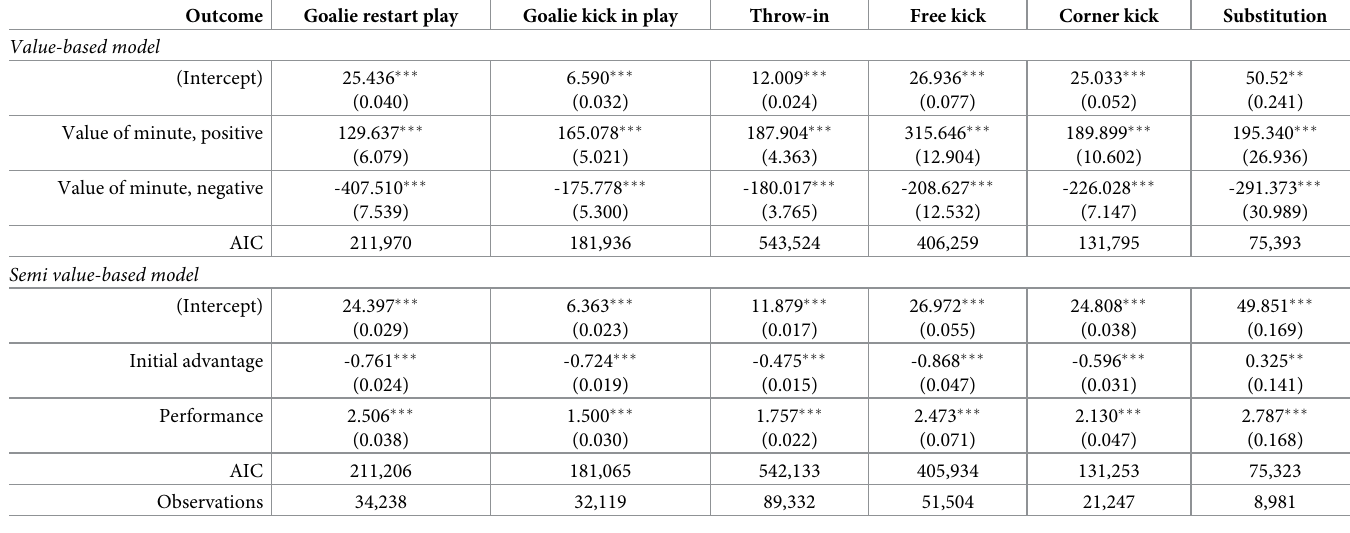
Table 1. Models of